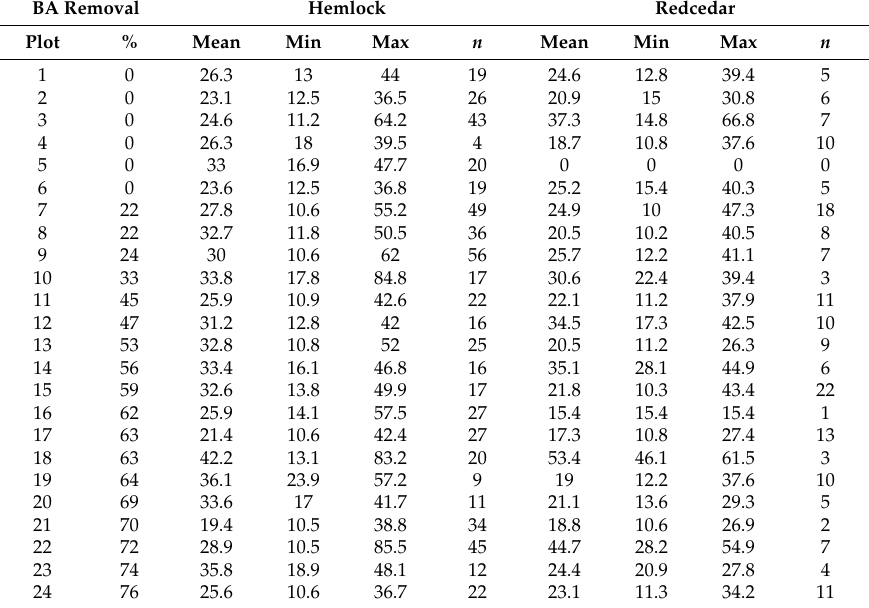
Table A1. Summary statistics for DBH of hemlock and western redcedar stems sampled in the 24 plots by percent basal-area removal and tree species.